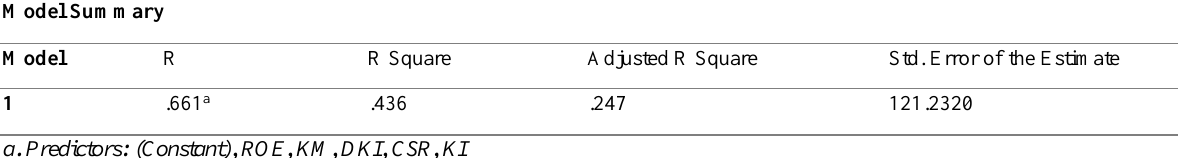
Table 5: Coefficient of Determination